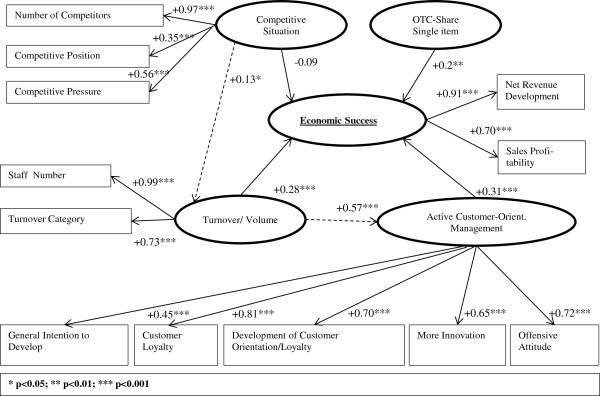
Results of the Structural Equation Model (SEM).